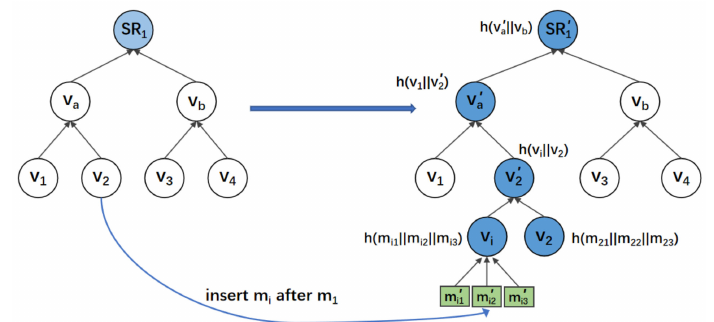
Figure 6. The example of inserting m i after data block m 1 .